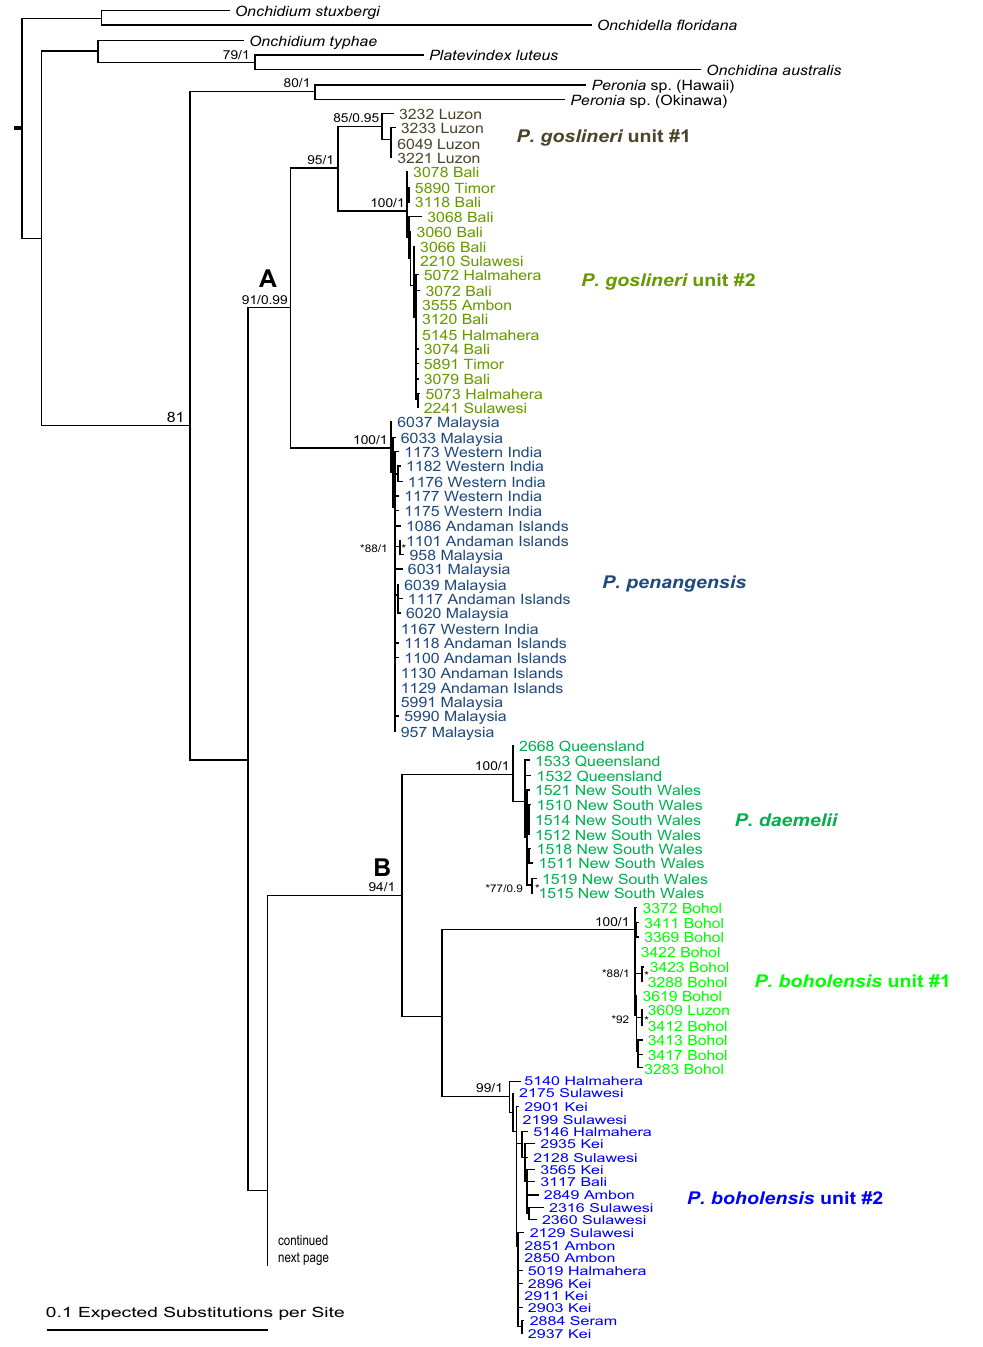
Fig. 2. (continued on next page) Phylogenetic relationships within Paromoionchis gen. nov. based on COI sequences of 166 individuals. Numbers by the branches are the bootstrap values (maximum likelihood analysis, ML) and the posterior probabilities (Bayesian analysis). Only numbers > 70% (ML) and > 0.9 (Bayesian) are indicated. Numbers for each individual correspond to unique identifiers for DNA extraction. All sequences for specimens of Paromoionchis gen. nov. are new, except for the three sequences of P. tumidus (Semper, 1880) comb. nov. from China found in GenBank (in which they were misidentified as Paraoncidium reevesii (J.E. Gray, 1850)). Information on specimens can be found in the lists of material examined and in Table 1. The letters A, B and C correspond to three clades referred to in the text. The color used for each (mitochondrial) unit is the same as that used in Figs 1 and